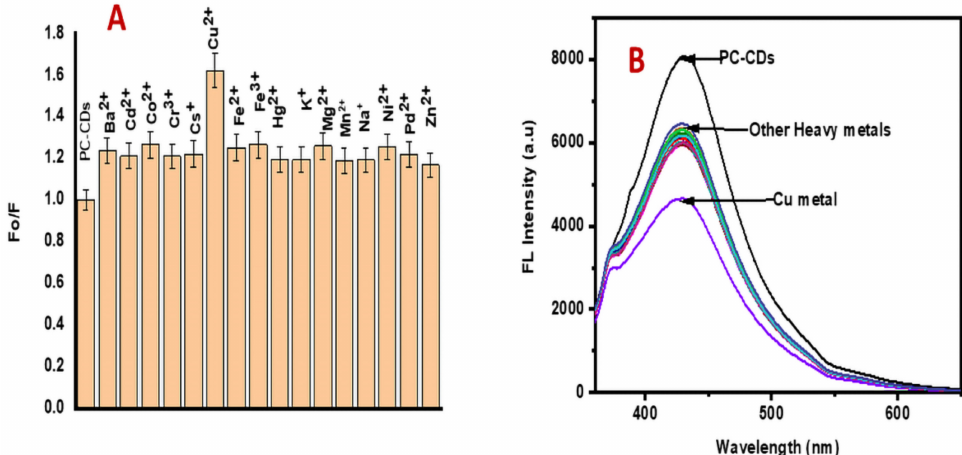
Figure 4. ( A ) Corresponding PL selectivity of Cu 2+ metal ion compared to that of other metal ions; ( B ) FL emission spectra of synthesized PC-CDs with different metal ions and Cu 2+